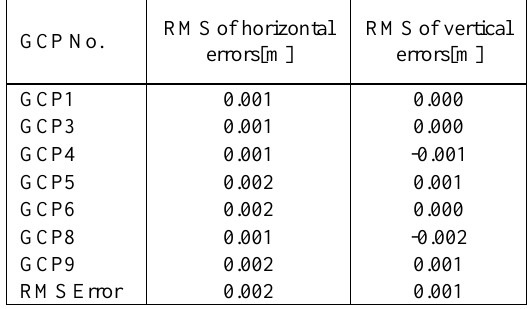
Figure 7. DSM of the study area